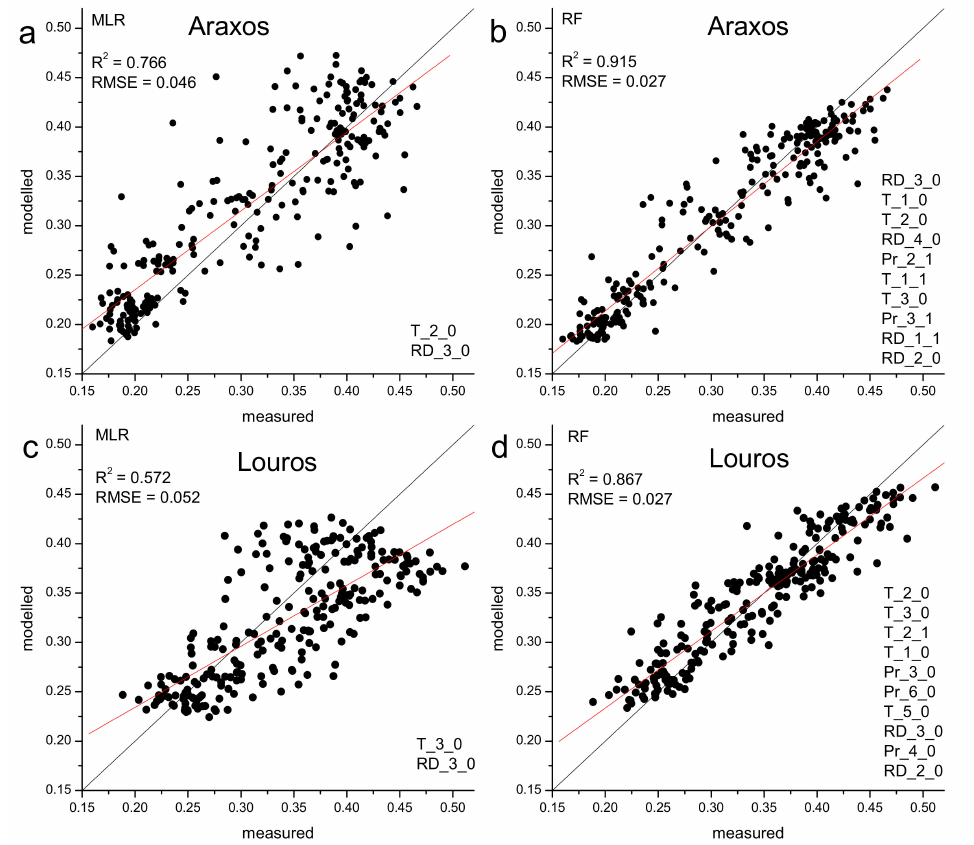
Figure 9. Regressions between measured and modelled EVI through multiple linear regression (MLR, a , c ) and random forest machine learning (RF, b , d ) for Araxos ( a , b ) and Louros ( c , d ). In multiple linear regressions ( a , c ) the two climatic parameters participating in the models are shown in the right lower corner of each graph. In machine learning models ( b , d ) the ten most important parameters are shown. In both cases parameter importance decreases from top to bottom. Black lines correspond to the 1:1 lines and red ones to the regression lines. Climatic parameters are described by an acronym for parameter description (T for temperature, Pr for precipitation, and RD for rain days) followed by a number showing the number of the corresponding months and a number corresponding to the lag time, for example T_2_1 refer to temperature of two months before one